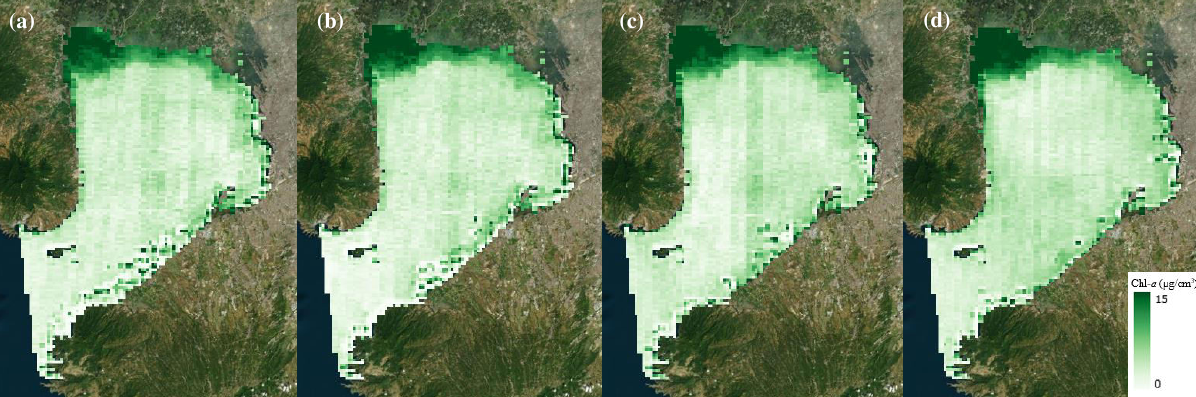
Figure 7. Chl- a maps for April 2, 2019 using the Dry model: (a) 9:10, (b) 9:30, (c) 9:50, and (d) 10:10 AM.